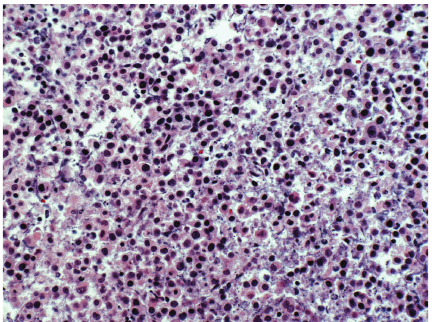
Figure 5: 20x: photomicrograph depicting the anaplastic compo- nent found to nearly replace the entire right adrenal gland. The cellular morphology here is slightly different from that found in the lung; here we see slightly less eosinophilic cytoplasm and the nucleoli are less